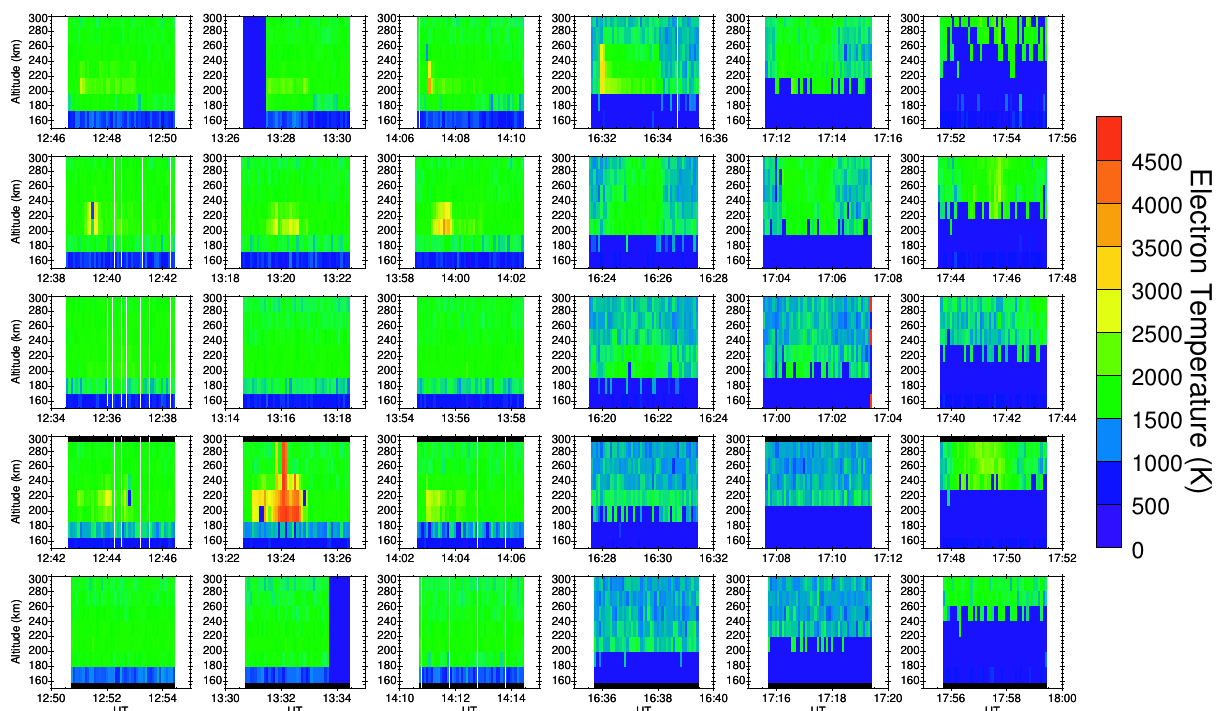
Fig. 7. Electron temperatures for 12:00–18:00 UT on 26 September 2002 for vertical heater pointing. The data are again shown using the format used for Figs. 5 and 6. There is much more variability in this data. Significant temperature increases, with values in excess of 5000K, corresponding to heater-on are present for FA − 6. There are also signatures in FA+6. No signature is present in FA.